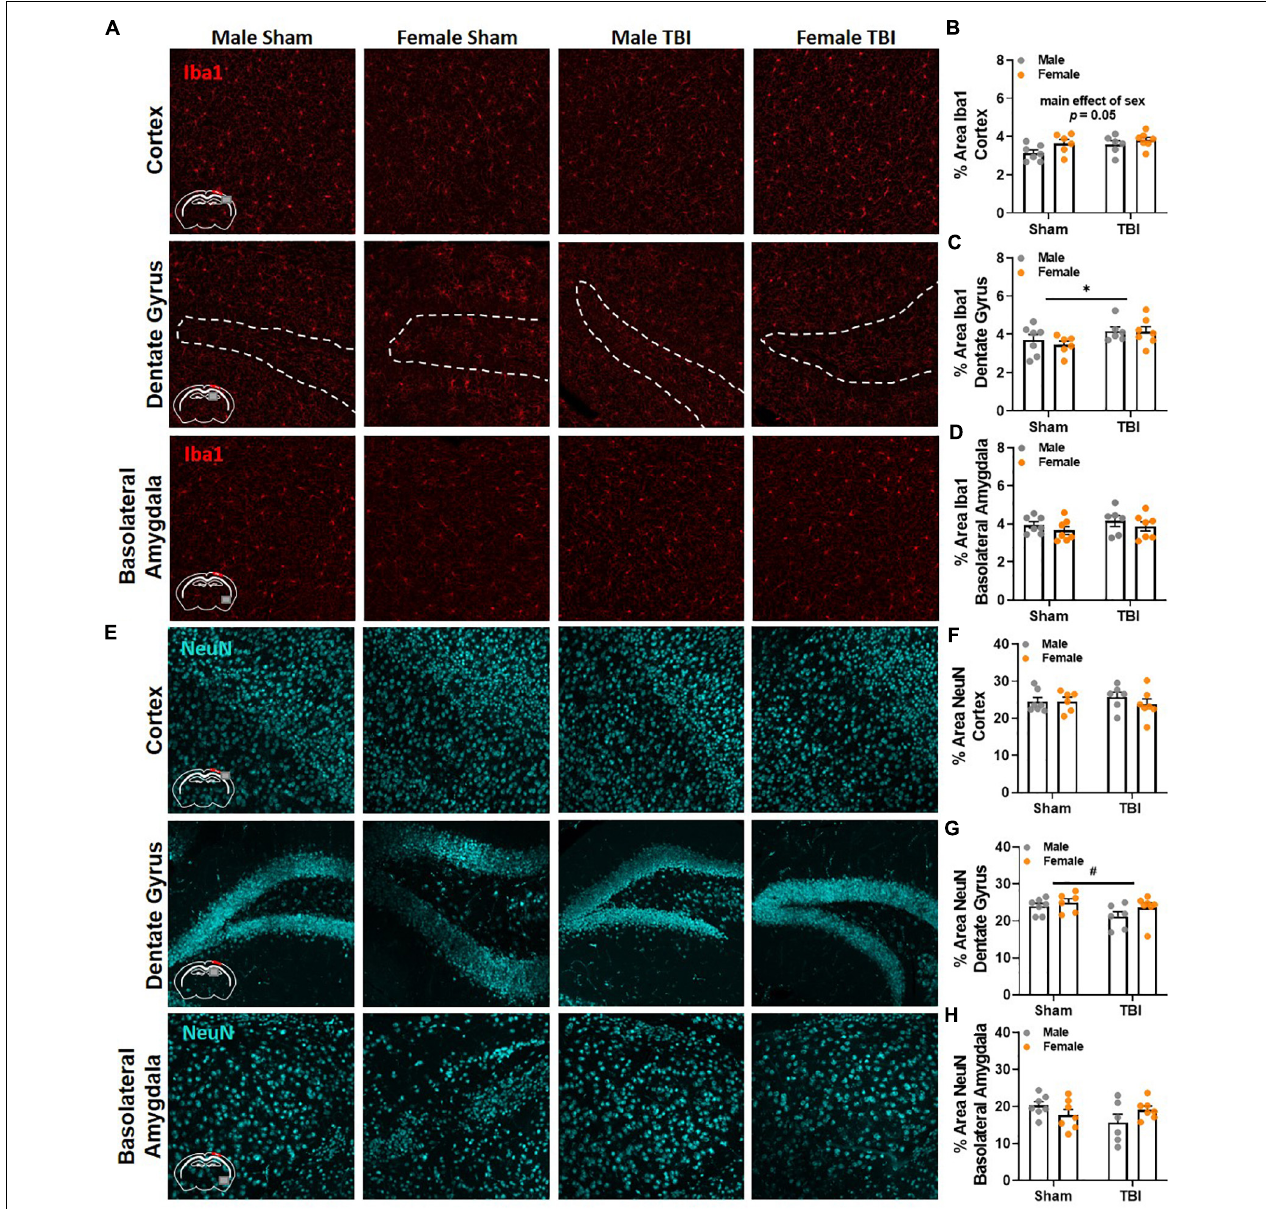
FIGURE 6 | Gross pathological change is absent near the site of injury and in the basolateral amygdala 17 weeks post-TBI. (A) Representative images of Iba1 labeling in the ipsilateral primary somatosensory cortex, dentate gyrus, and basolateral amygdala 17 weeks post-injury. (B) Percent area of Iba1 was higher in female mice than male mice in the cortex; but a main effect of sex fell short of statistical significance. (C) TBI increased percent area of Iba1 labeling in the dentate gyrus. (D) No significant differences in Iba1 percent area were detected between experimental groups in the basolateral amygdala. (E) Representative images of NeuN labeling in the ipsilateral primary somatosensory cortex, dentate gyrus, and basolateral amygdala 17 weeks post-injury. (F) No significant differences in NeuN were detected between experimental groups in the cortex. (G) No significant differences in NeuN were detected in the dentate gyrus, but a trending main effect of TBI is present. (H) No significant differences in NeuN percent area were detected between experimental groups in the basolateral amygdala. N = 6–7/group; error bars indicate SEM. Main effects are identified in the figure. * p < 0.05; # p <